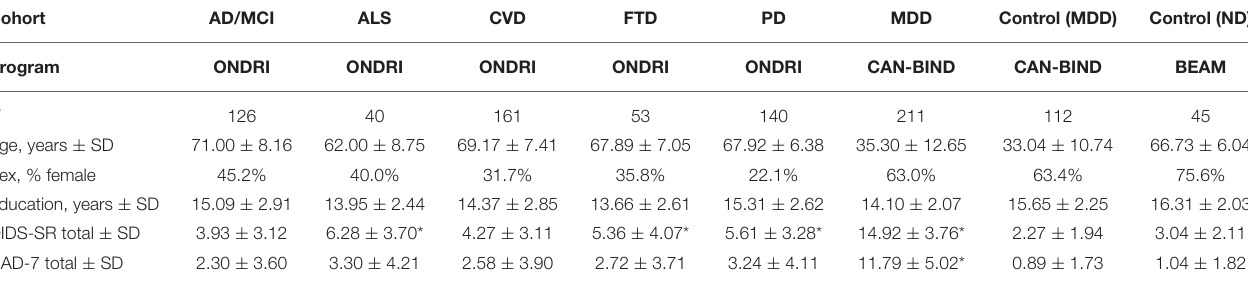
TABLE 3 | Demographic and clinical